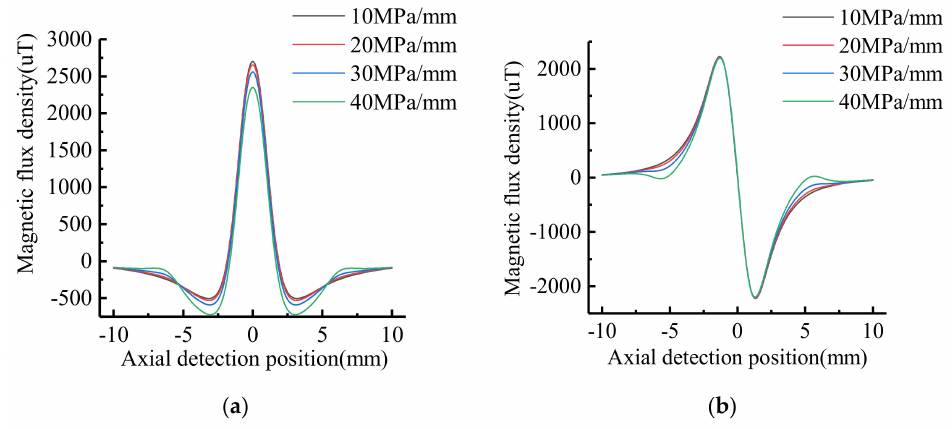
Figure 16. Signal characteristics of defects with different stress gradient: ( a ) Tangential signal; ( b ) Normal